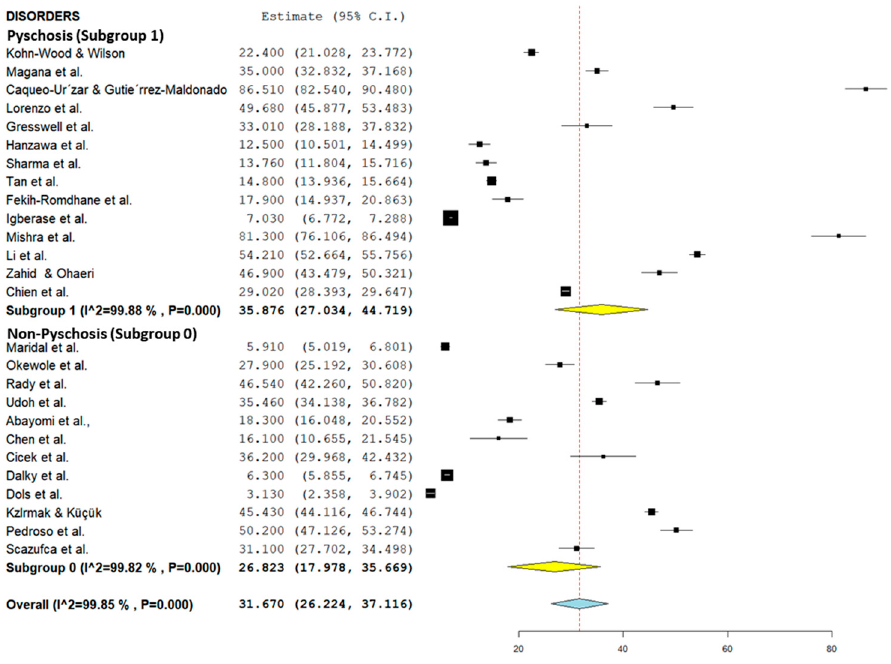
Figure 5. Subgroup forest plot of psychotic and non-psychotic disorders (Psychosis: